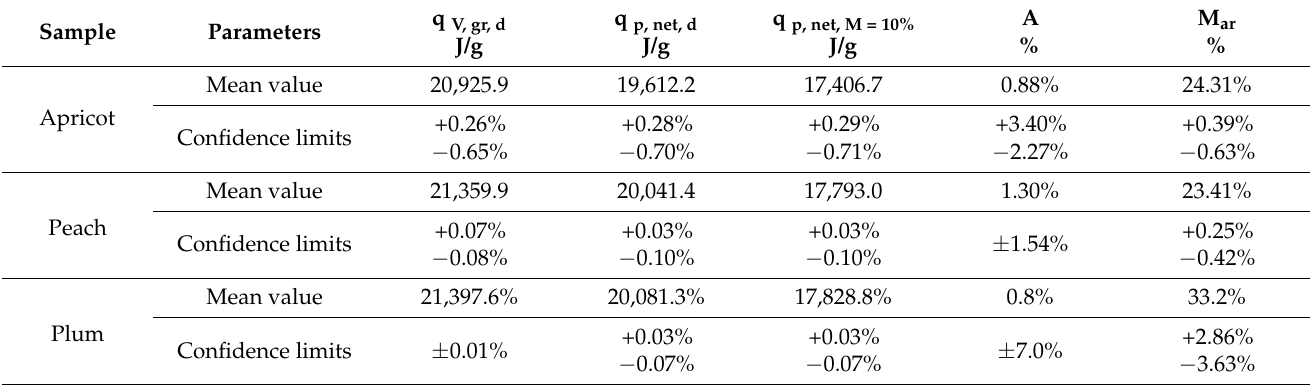
Table 5. Calorific results, ash content, and moisture at